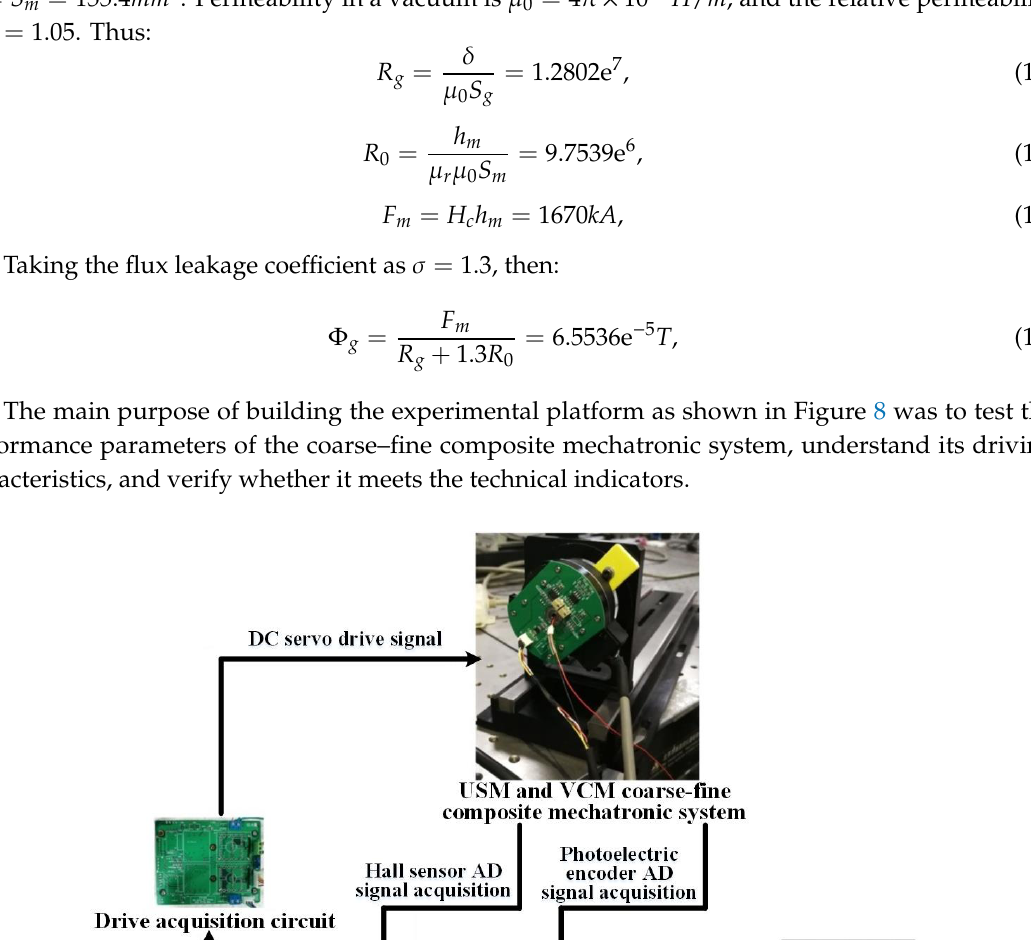
Figure 9. The Bode diagram of VCM open loop sweep frequency. ( a ) Amplitude frequency curves, in which the output signal is the angle signal after Hall sensor calibration; ( b ) amplitude frequency curves, in which the output signal is the incremental encoder angle signal; ( c ) phase frequency curves, in which the output signal is the angle signal after Hall sensor calibration; ( d ) phase frequency curves, in which the output signal is the incremental encoder angle signal. The closed loop of the angle position calibrated by the Hall effect sensor is used for the frequency sweeping identification. In Figure 10a–d, the information of the Hall effect sensor angle position and incremental encoder angle position was acquired at the same time. Bandwidth is defined as the frequency value when the closed-loop amplitude-frequency characteristic curve drops to −3 dB. Thus,